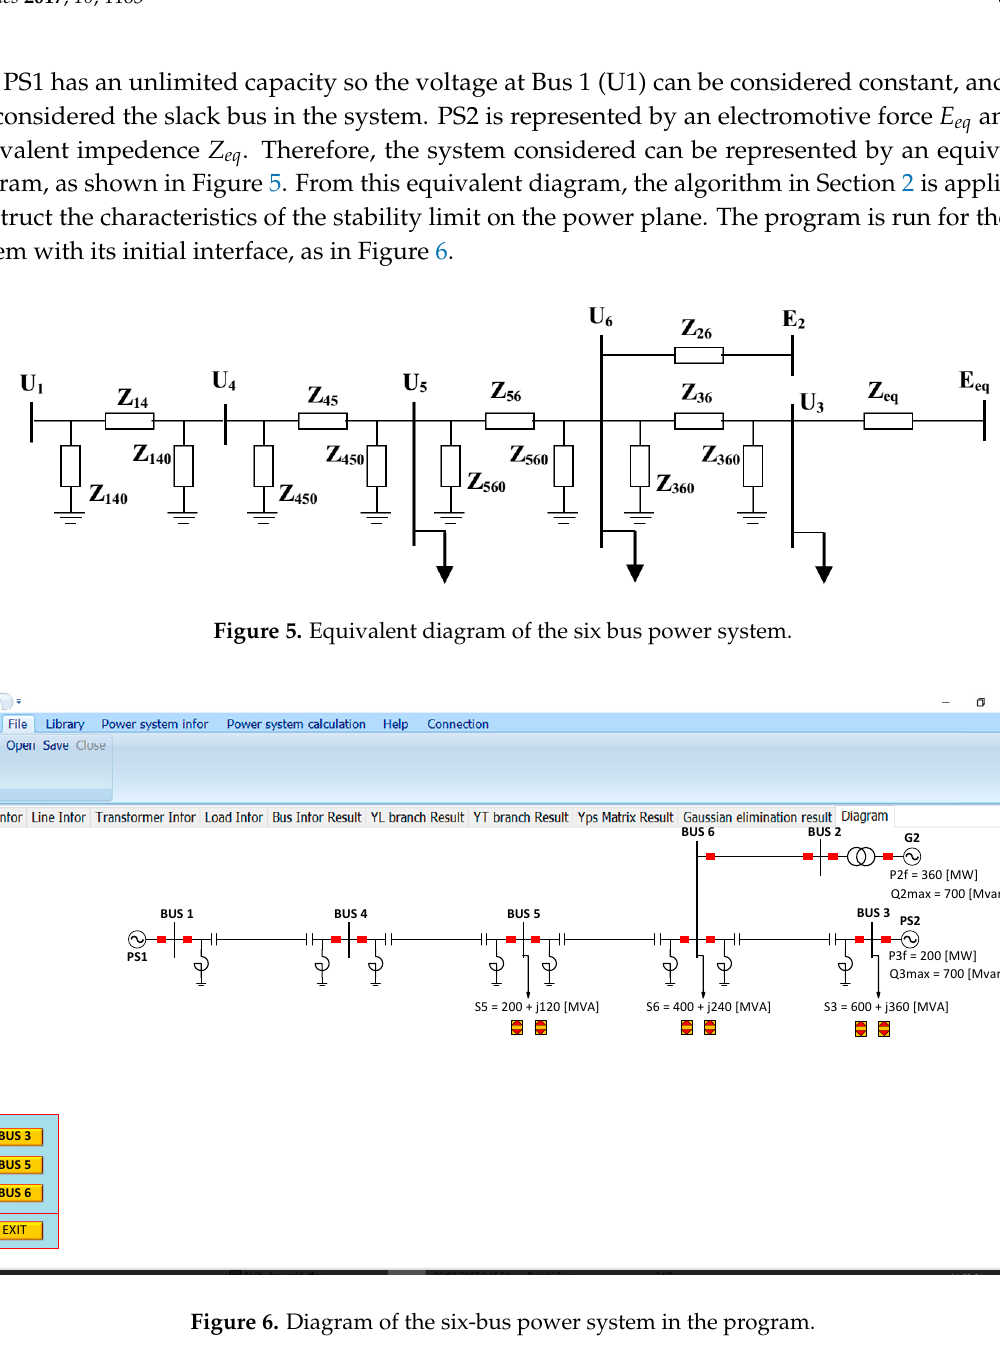
Figure 4. Six bus power system.